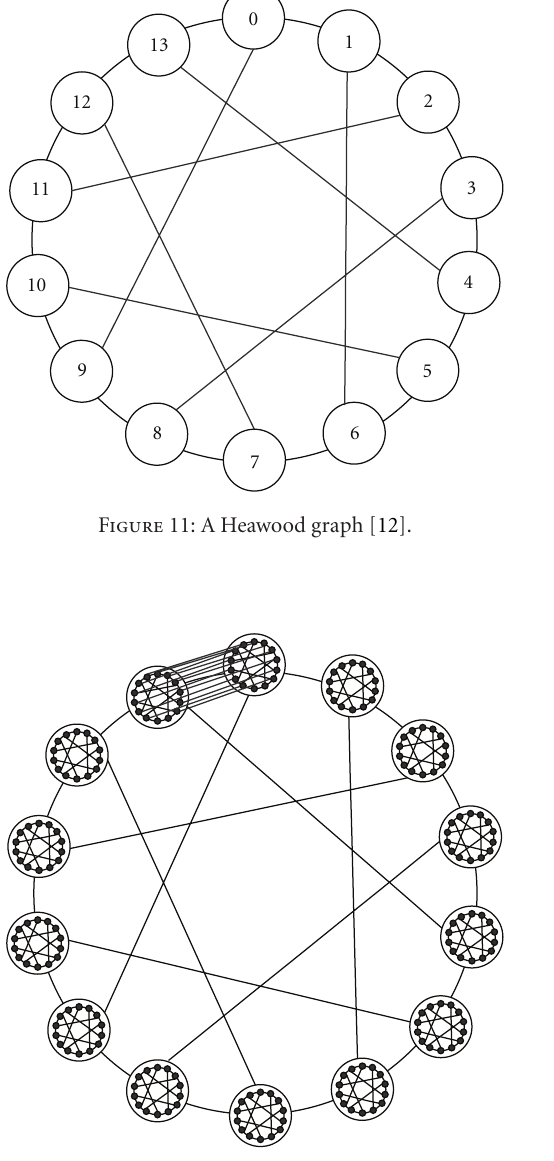
Figure 14: A 2-dimentinal REH HIN